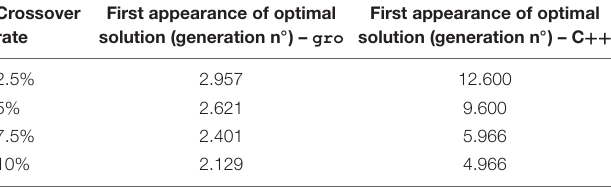
TABLE 4 | Crossover rate variation for SGA.